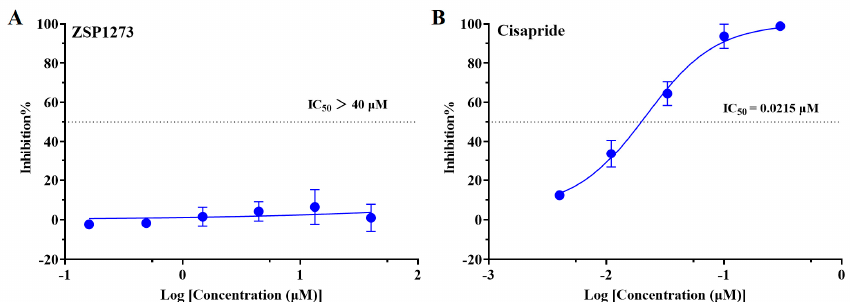
Figure 2. (A): Dose − response curves and IC 50 values of ZSP1273 on the hERG potassium channel current; (B): Dose − response curves and IC 50 values of cisapride on the hERG potassium channel current.The IC 50 values of the compounds were calculated by fitting them with the following equation: I/Io = 1/{1 + ([C]/IC 50 ) ^ n}, where Io and I are the hERG potassium current amplitudes before and after administration, respectively, while [C] is the compound concentration, and n is the Hill factor